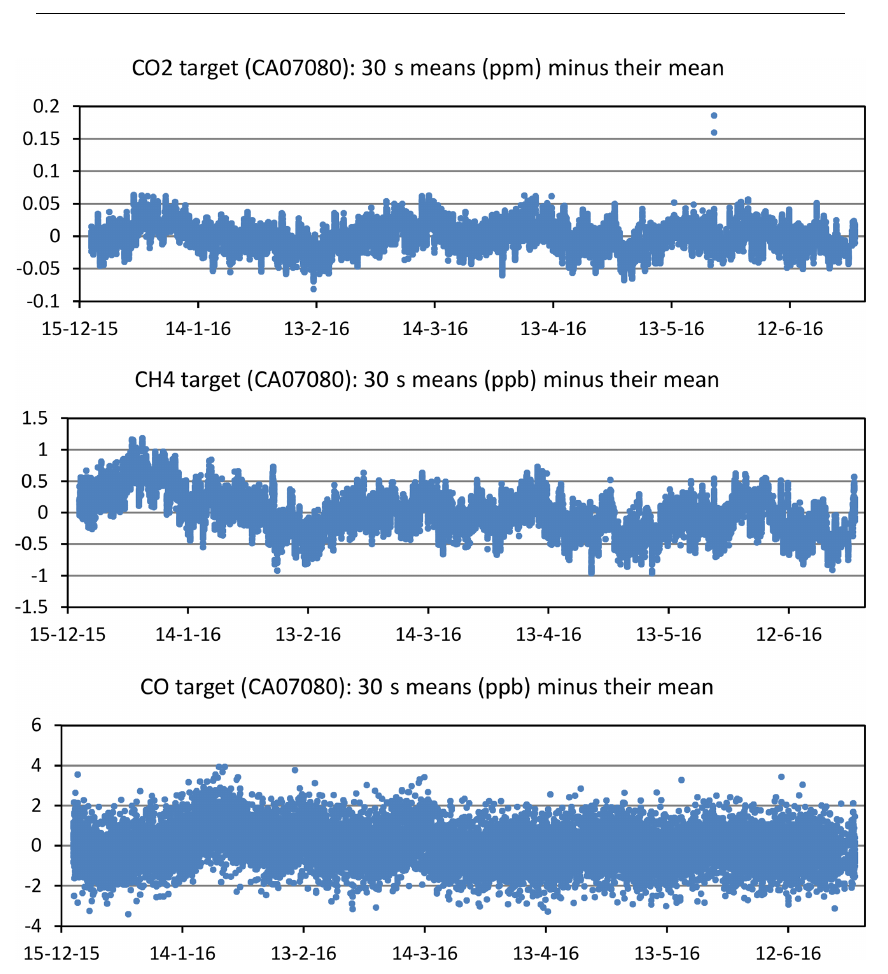
Figure 14. Time series of mole fraction assignments for one of the target